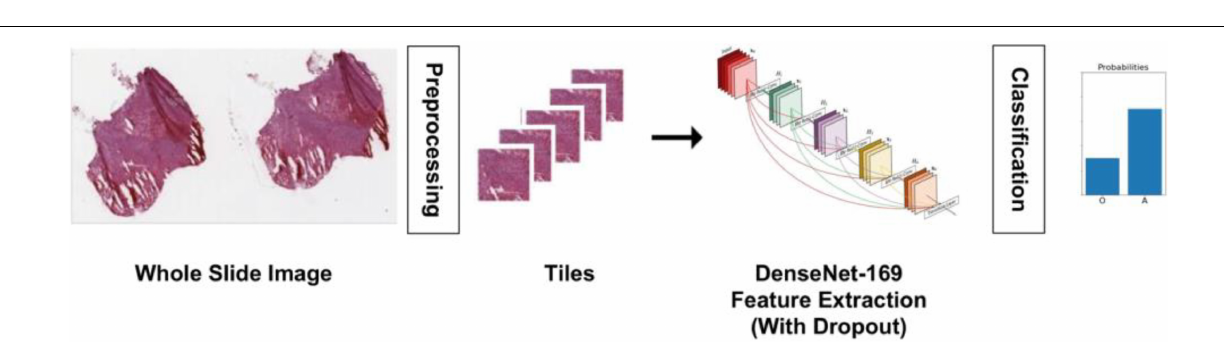
Frontiers in Neuroscience |